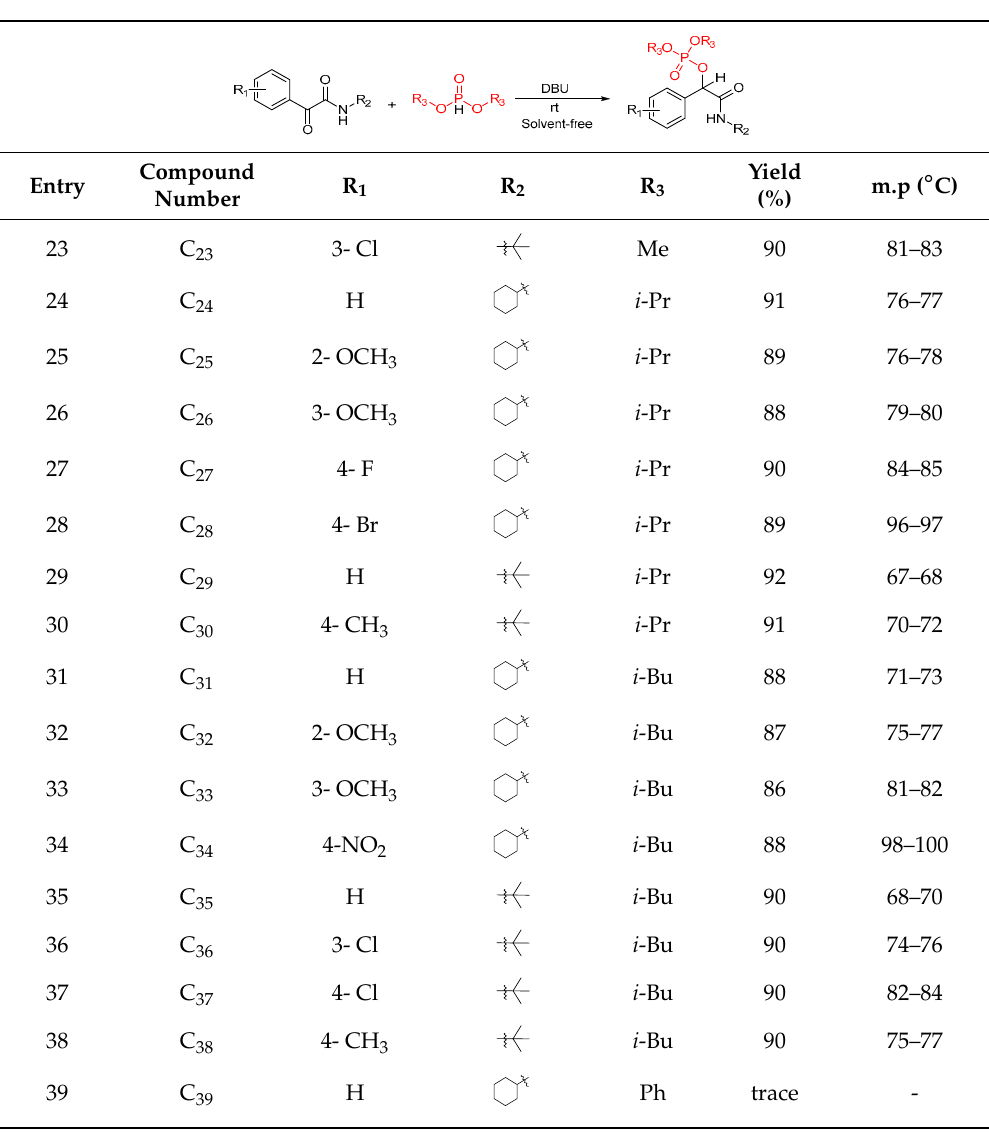
Table 2. The synthesis of a series of α‐ Phosphate Amide derivatives a .